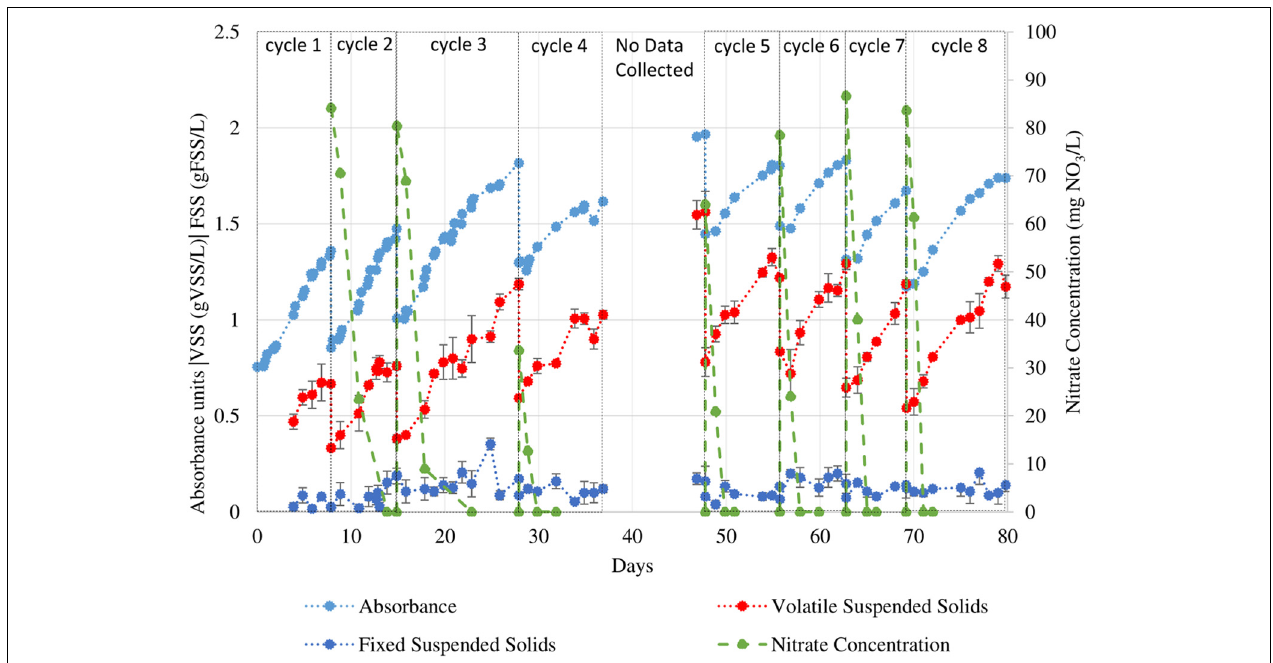
FIGURE 1 | VSS, FSS, and OD 550 readings of N. gaditana under 12h/12h light/dark sequential batch cycles. During the period when data collection was not possible the PBR operation was maintained. Error bars indicate the 95% confidence interval of the solids analyses measurements (obtained from triplicate readings).